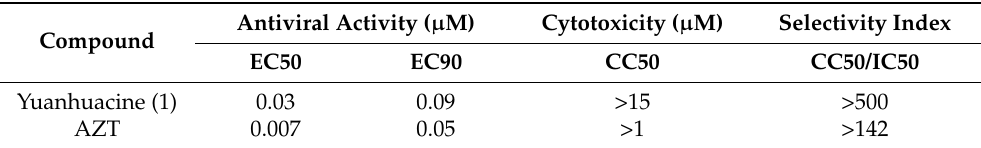
Table 2. Anti-HIV and selectivity of yuanhuacine A in PBMC.